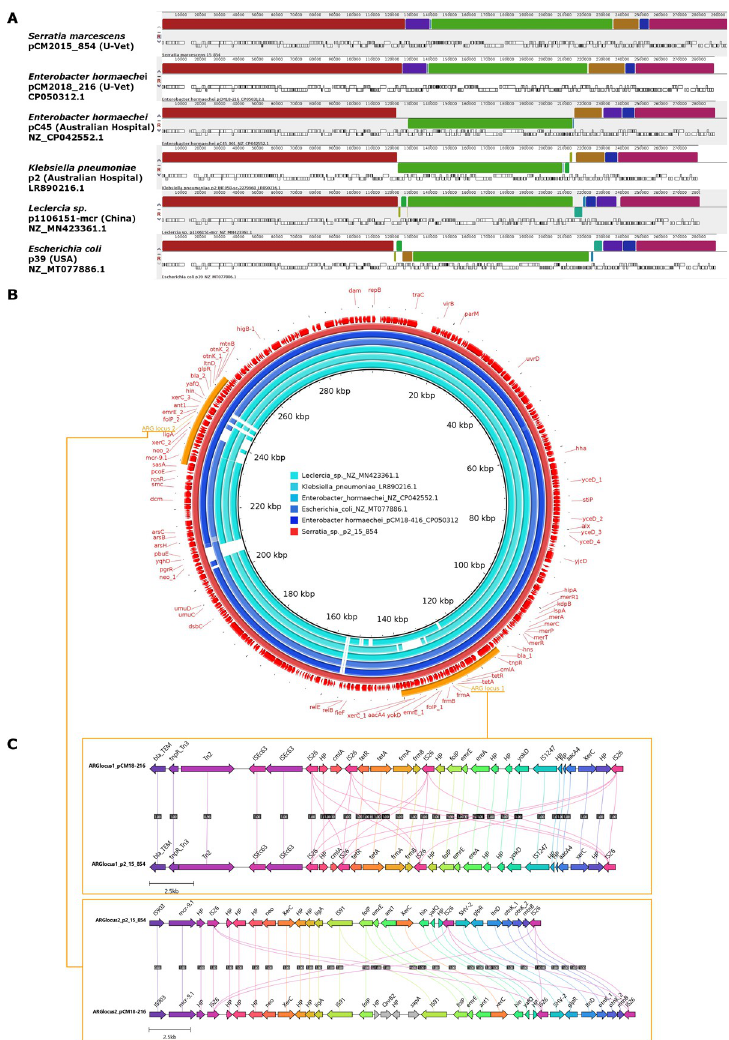
Fig 5. Comparison of IncHI2 plasmids from MDR Serratia spp., E . hormachei , Klebsiella pneumoniae and E . coli , showing the high similarity between the two replicons found at the U-Vet, and suggesting a common origin for this mobile genetic element within the hospital. A) Mauve sequence alignments, showing local blocs of co-linearity and structural conservation between plasmids pCM2015_854 from Serratia (top), pCM2018_216 from E . hormachei (second top) and other most-closely related plasmids. B) Comparative alignments of plasmid sequences by BRIG showing the conservation of antimicrobial resistance loci. The four outermost rings (red-orange) correspond to the plasmid carried by the representative MDR Serratia strain CM2015_854, used as a reference. The inner rings (shades of blue) represent highly similar plasmids from other Enterobacteriaceae . From outer to inner rings: 1- plasmid pCM2015_854 annotations (red), 2- ARG loci (orange), 3- map of annotated features (red), 4- nucleotide sequence (red), 5- plasmid pCM2018_216 sequence (dark blue), 6- to 8- other plasmids sequences (medium to light blue). C) Local genetic maps of ARG loci of plasmids pCM2015_854 from Serratia and pCM2018_216 from E . hormachei .